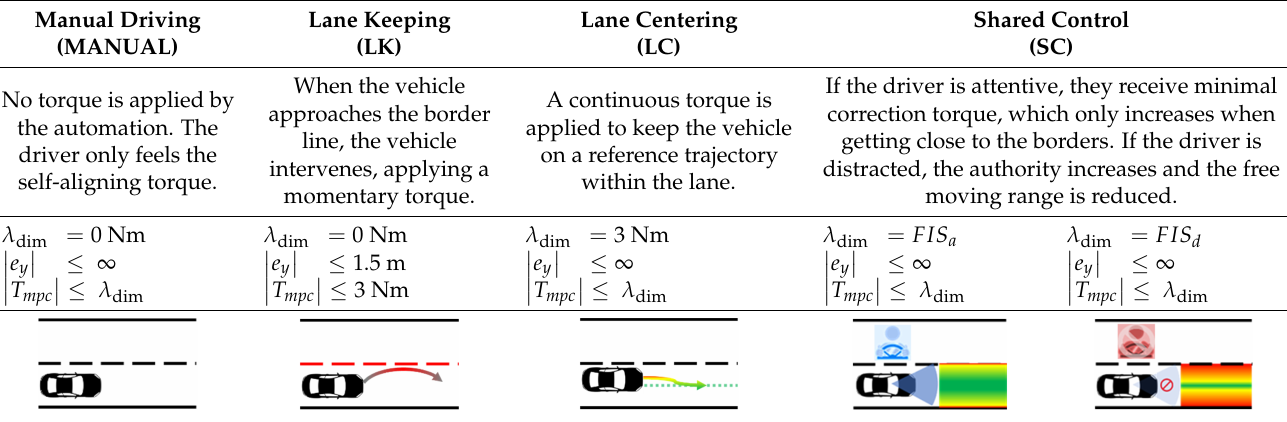
Table 7. The four driving modes for the experimental